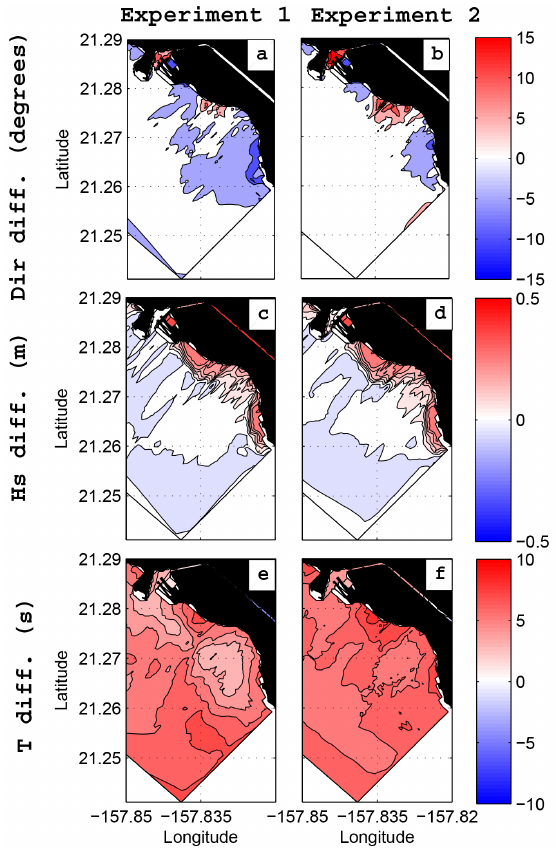
Figure 5. Maps of differences in wave direction ( a, b – unit: de- grees from N – contour interval (c.i.) 5 ◦ ), wave significant height H s ( c, d – unit: meters – c.i. 0.05m), and wave period T ( e, f – unit: seconds – c.i. 1s), between the WAVECOUPLE and WAVEFORCE simulations (WAVECOUPLE–WAVEFORCE). Comparisons of ex- periment 1 are in the left column and for experiment 2 in the right column. The coupled simulation presents significantly higher H s near the shore and larger T throughout the model domain for both